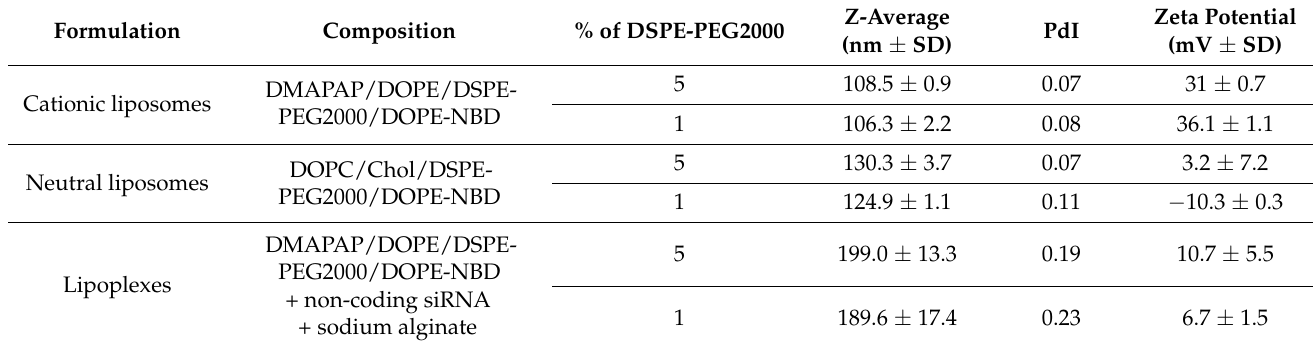
Table 1. Liposomes’ and lipoplexes’ physicochemical characteristics expressed as mean ± SD of three batches for each